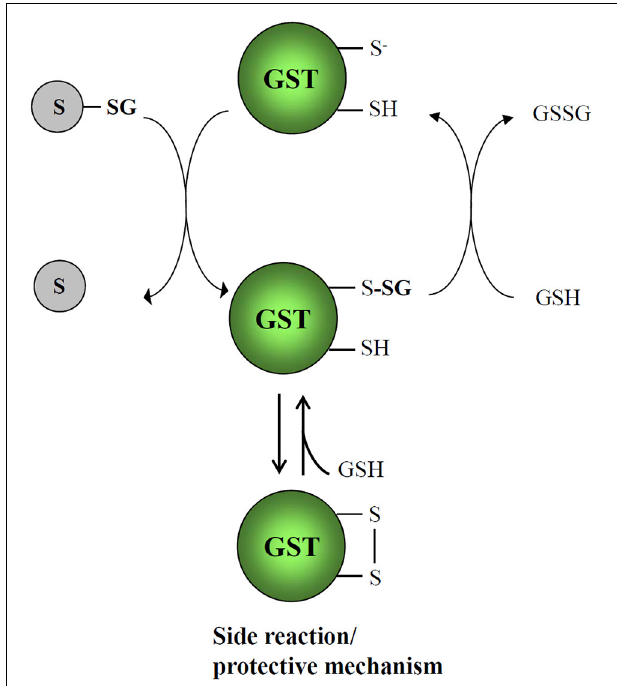
FIGURE 6 | Catalytic mechanisms of Cys-GSTs. The deglutathionylation of GSH-conjugated substrates occurs via the nucleophilic attack of the catalytic cysteine which is assumed to be at least partially under the thiolate form at physiological pH, owing to a decreased pKa value. Consequently, the catalytic cysteine is itself glutathionylated and it is regenerated using a glutathione molecule. For Cys-GSTs having another cysteine either in the active site (some DHAR isoforms) or at proximity (some GSTL isoforms), the identification of proteins with an intramolecular disulfide suggests that this might constitute either an intermediate step of the catalytic mechanism or more likely a protective mechanism that prevents oxidation of the catalytic cysteine into sulfenic acid forms or eventually higher oxidized forms as sulfinic or sulfonic acid forms. In the case of the formation of a disulfide an additional glutathione molecule would be required. It may be that thioredoxin participate to this reduction step as DHAR was isolated as a thioredoxin